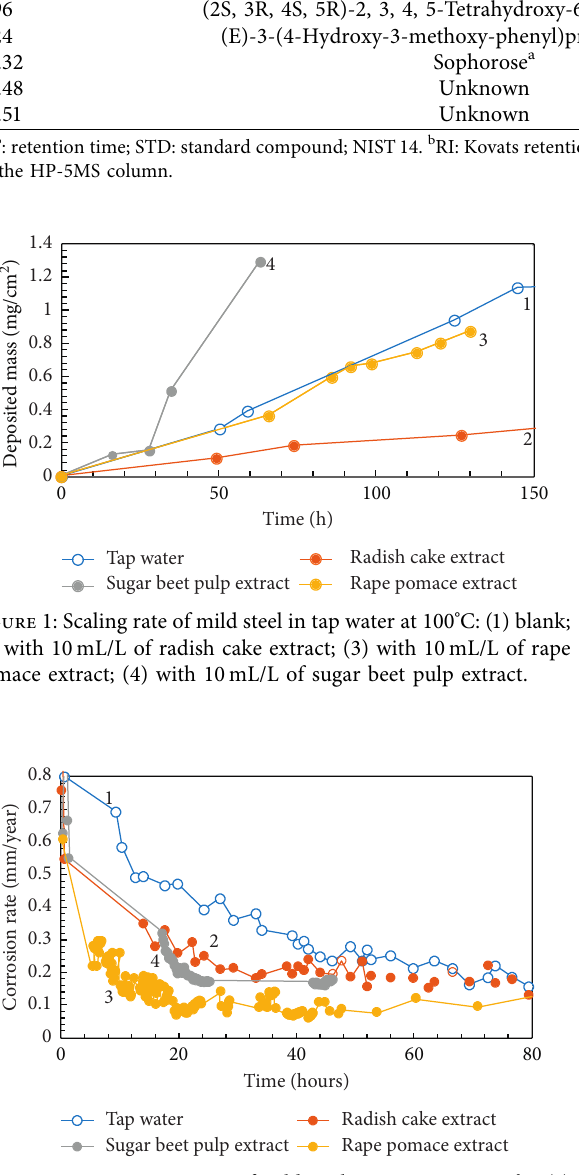
Figure 2: LPR corrosion rate of mild steel in tap water at 100 ° C: (1) blank; (2) with 10 mL/L of radish cake extract; (3) with 10mL/L of rape pomace extract; (4) with 10mL/L of sugar beet pulp